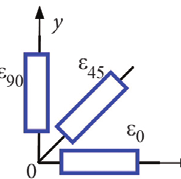
Fig. 16. Analysed cross-sections at node 2 (Fig. 12)